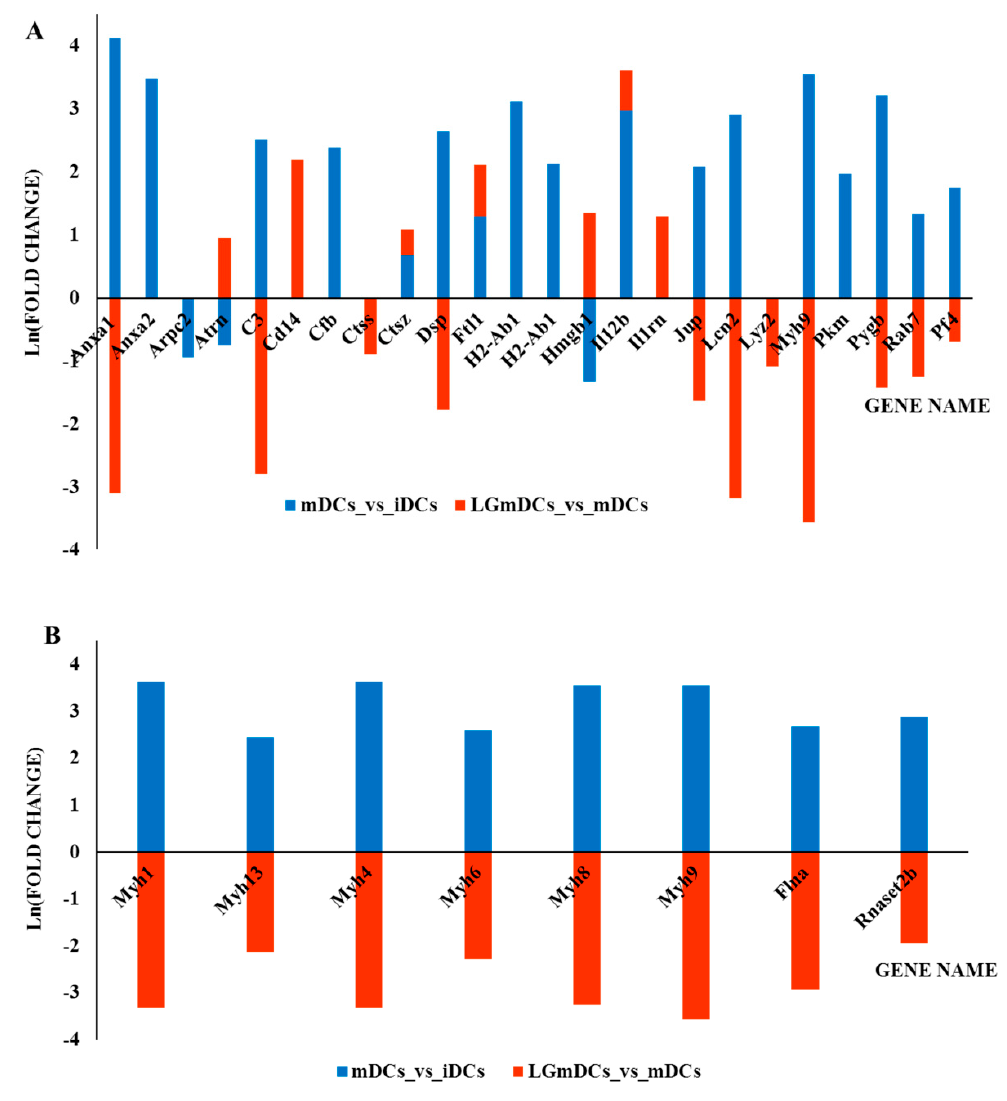
Figure 4. Bar diagram summarizing the most relevant results of the quantitative proteomic analyses and reporting the natural logarithm (Ln) of fold change values obtained comparing mDCs vs. iDCs and LGmDCs vs. mDCs. Fold change values are reported in Table 1. Positive values of Ln (fold change) indicate an increase in protein amount, while negative values of Ln (fold change) indicate a decrease in protein amount. ( A ) Proteins mainly involved in the immune response. ( B ) Proteins mainly involved in contractile machinery. These proteins showed a significant increase in fold changes when comparing mDCs vs. iDCs (blue bars) and a dramatic decrease when comparing LGmDCs vs. mDCs (red bars).